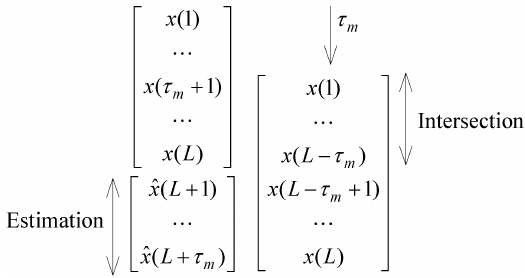
Figure 7. Estimation of future GDP values.